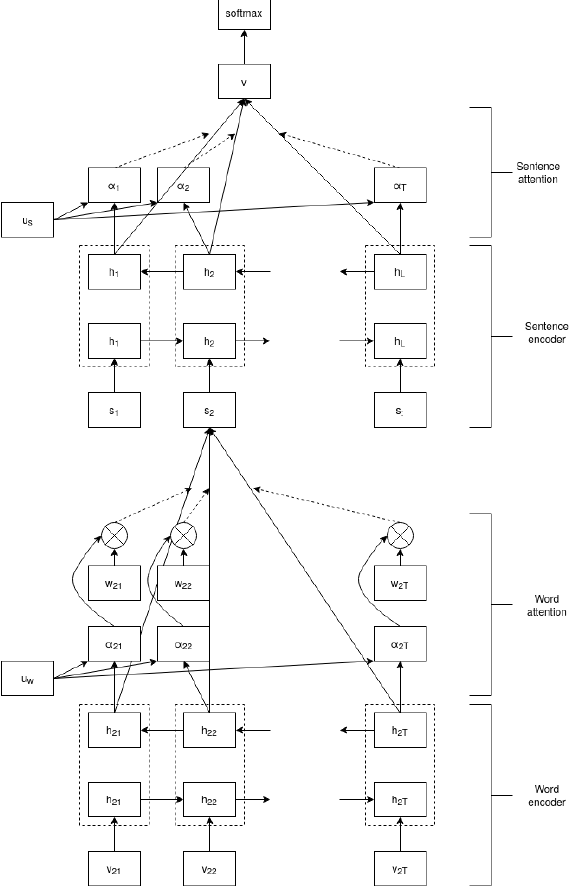
Figure 18. The architecture of our Hierarchical Weighted Attention Network. Table 3. Averaged overall classification accuracy (in percent) for HAN and variants of HWAN; cross-validation for Ohsumed, BBC and BBCSport, test-train split for Reuters and 20Newsgroups. Restricting input length at 30 sentences 100 words each. Numbers in bold denotes results better than baseline HAN